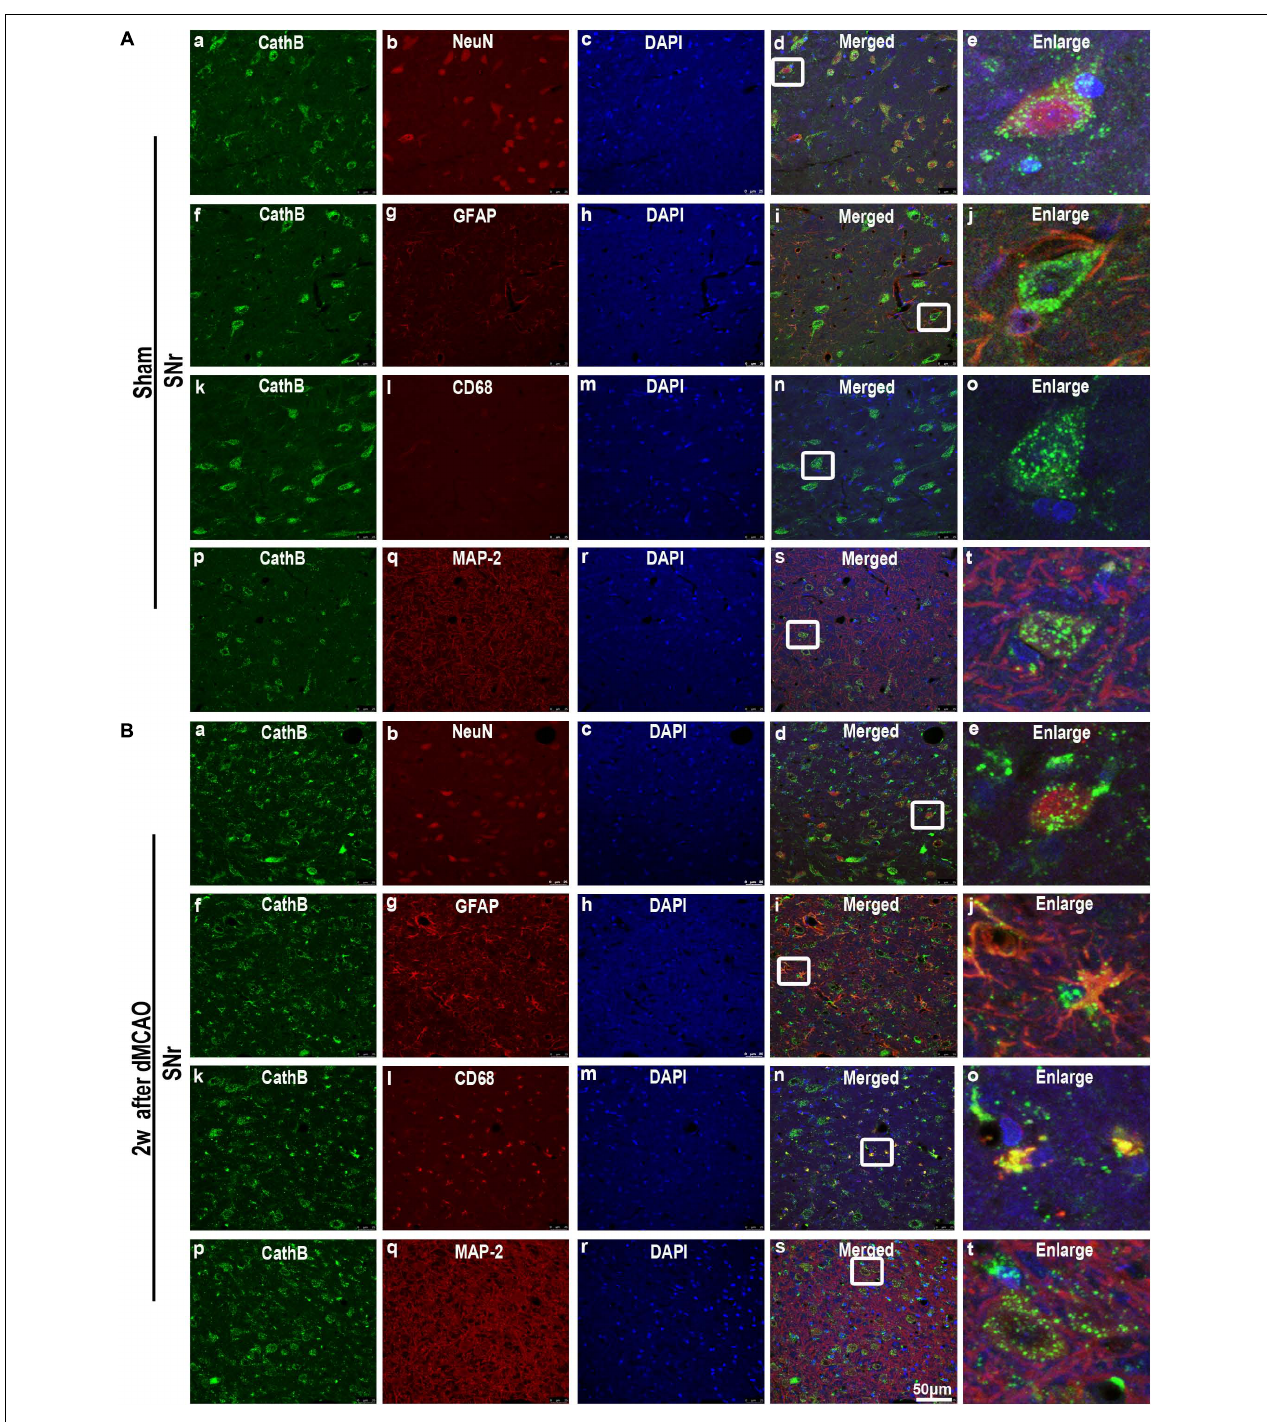
FIGURE 5 | Cellular localization of CathB in the ipsilateral SNr after dMCAO. (A) Representative images of fluorescent triple-staining of CathB (green), DAPI (blue) and NeuN (red); CathB (green), DAPI (blue), and GFAP (red); CathB (green), DAPI (blue) and CD68 (red); CathB (green), DAPI (blue), and MAP-2 (red) in the ipsilateral SNr at sham-operated group. The overlapped images show that NeuN is surrounded by CathB (a–e) . No colocalization of CathB with GFAP (f–j) , CD68 (k–o) , and MAP-2 (p–t) was observed in the ipsilateral SNr at sham-operated group. (B) Representative images of fluorescent triple staining of CathB (green), DAPI (blue), and NeuN (red); CathB (green), DAPI (blue), and GFAP (red); CathB (green), DAPI (blue), and CD68 (red); CathB (green), DAPI (blue), and MAP-2 (red) in the ipsilateral SNr at 2 weeks after dMCAO. The overlapped images show that NeuN is surrounded by CathB (a–e) ; and CathB is colocalized with GFAP (f–j) , CD68 (k–o) , and MAP-2 (p–t) in the ipsilateral SNr at 2 weeks after dMCAO. Scale bar, 50 µ m. NeuN, neuron-specific nuclear-binding protein; GFAP, glial fibrillary acidic protein; MAP-2, microtubule-associated proteins-2; CD68, cluster of differentiation 68; Sham, sham-operated; w,